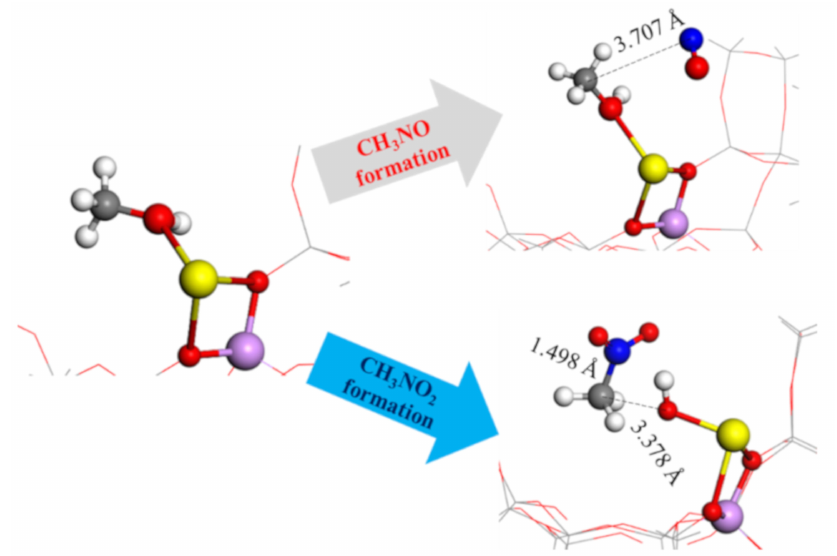
Figure 9. The scheme of CH 3 NO and CH 3 NO 2 formation pathway and the optimized geometry structure of CH 3 NO 2